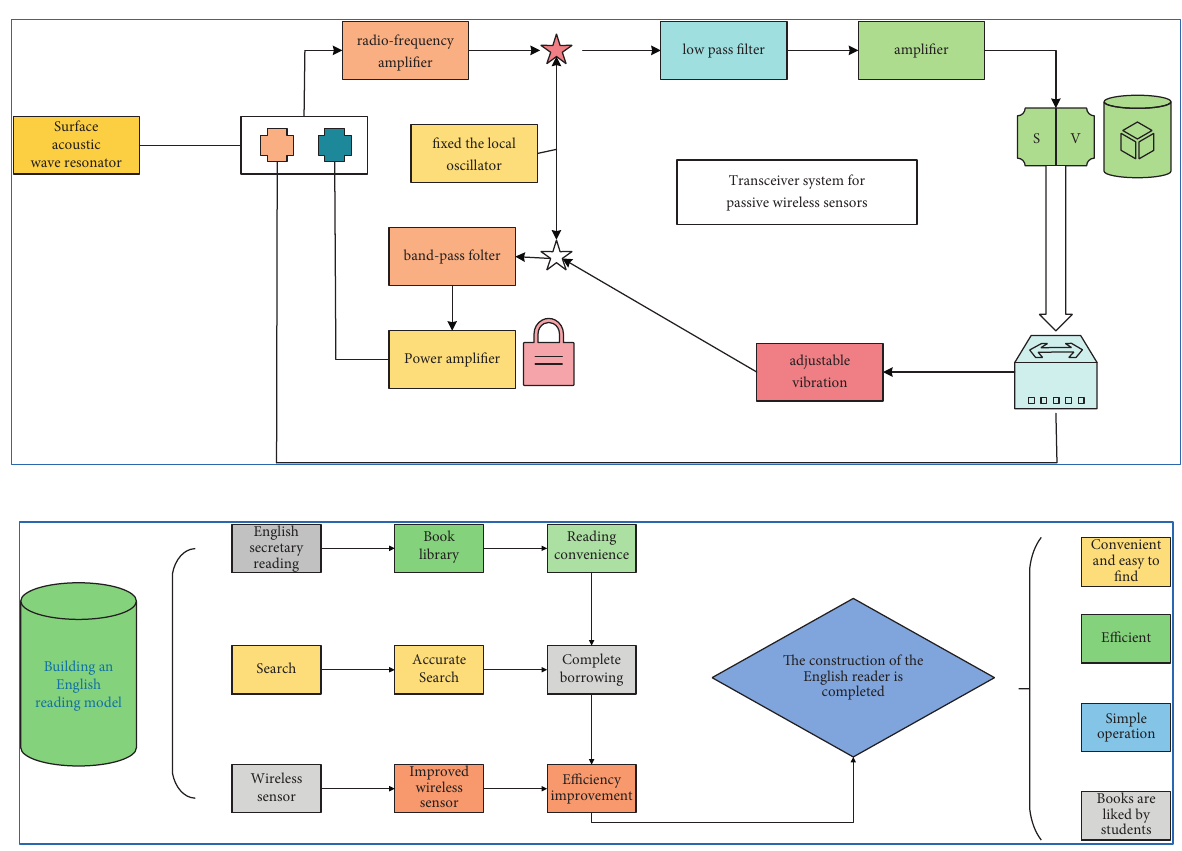
Figure 3: English reading model construction. Table 1: Parameter settings of particle swarm algorithm.